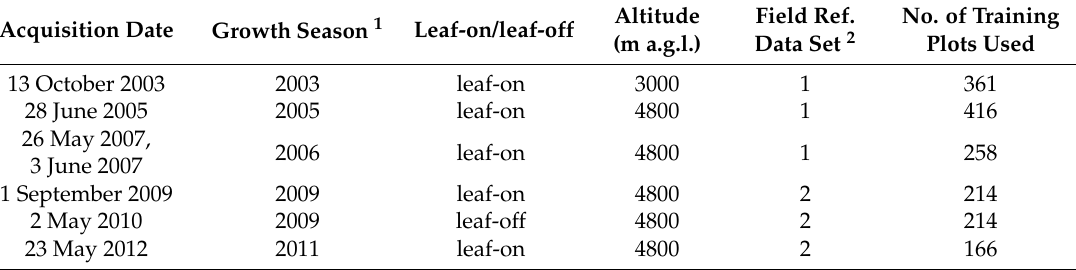
Table 3. Digital aerial images and training plots used for modeling the target